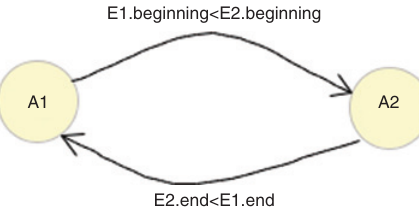
Figure 2: MSDR-CH Rule Represented by a Graph.